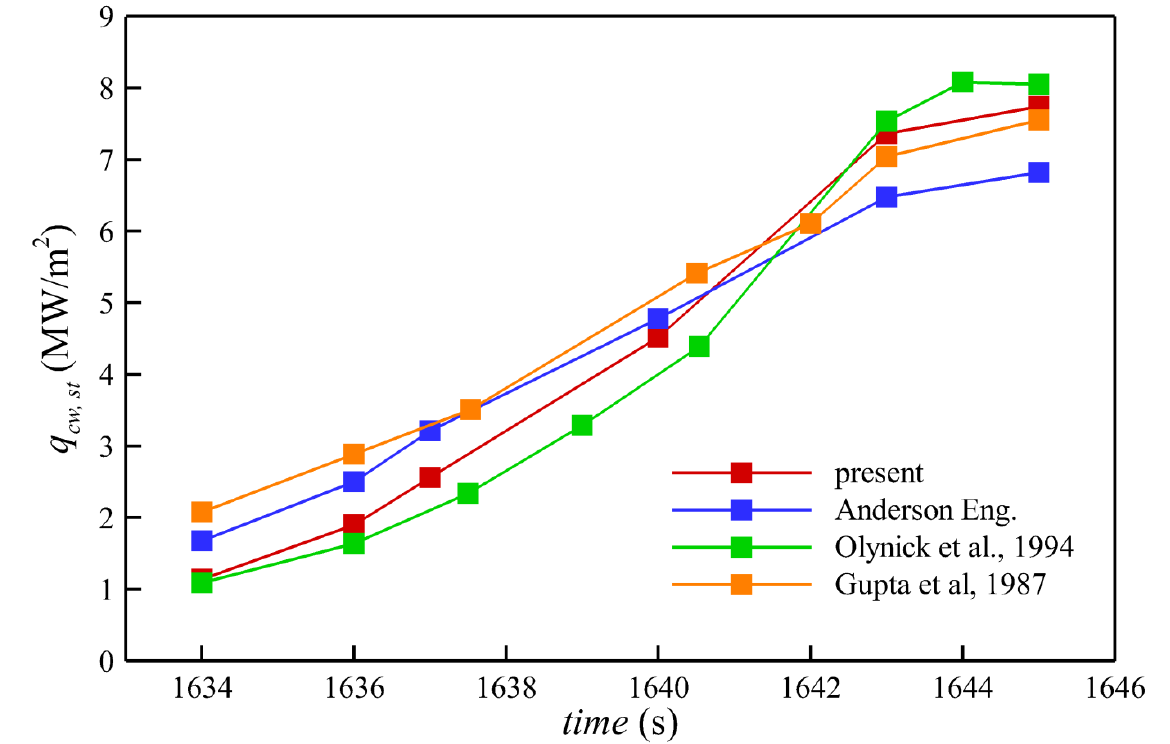
Figure 2. Convective heating at the stagnation point of Fire II predicted by the present algorithm (present), Anderson’s engineering relation (Anderson Eng.), Olynick et al., and Gupta et al.